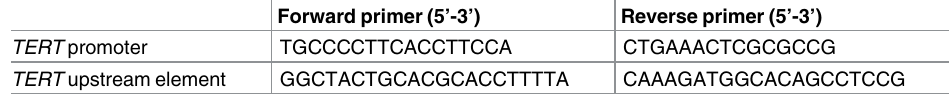
Table 3. Chromatin immunoprecipitation